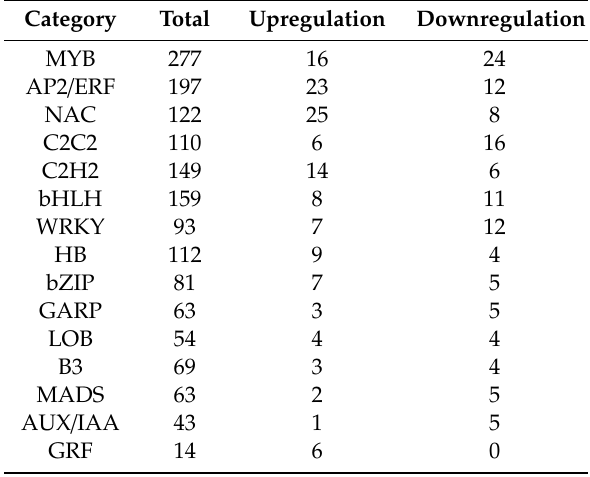
Table 6. Response of transcription factors in the comparison of AL vs.